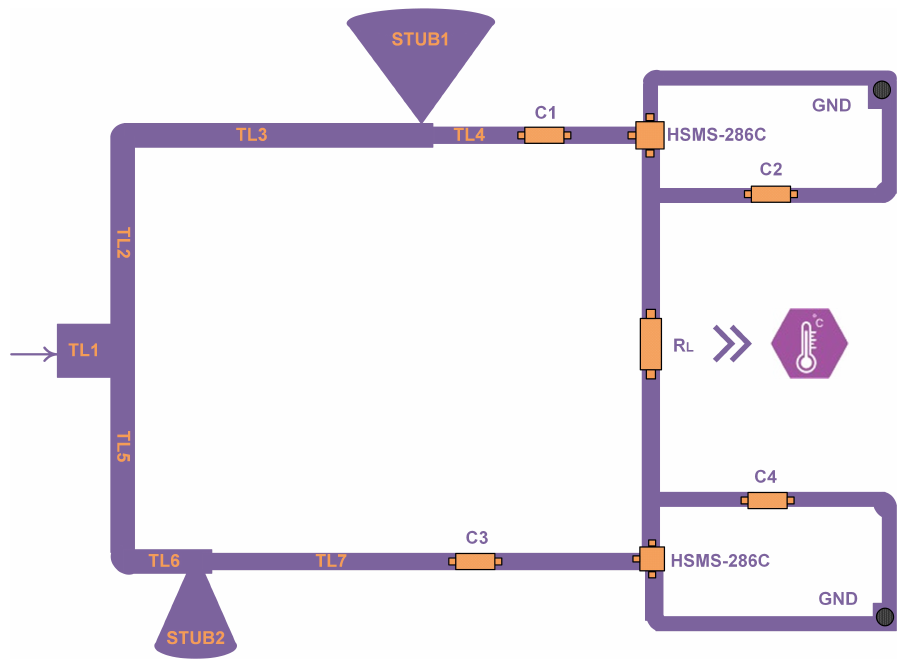
Figure 10. Layout of the proposed